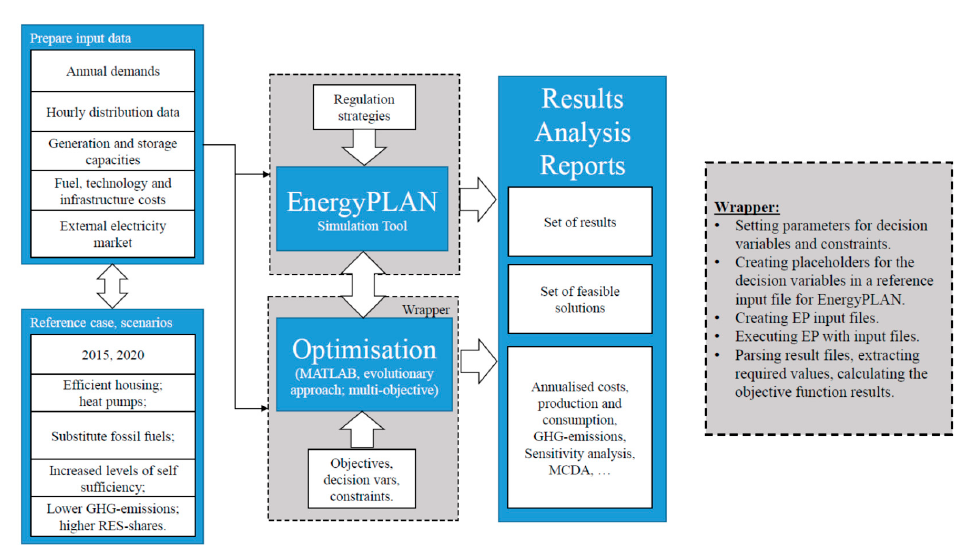
Figure 1. Schematic diagram of the interface between EnergyPLAN (simulation) and the multi-objective evolutionary algorithm (MOEA) (multi-objective optimization).